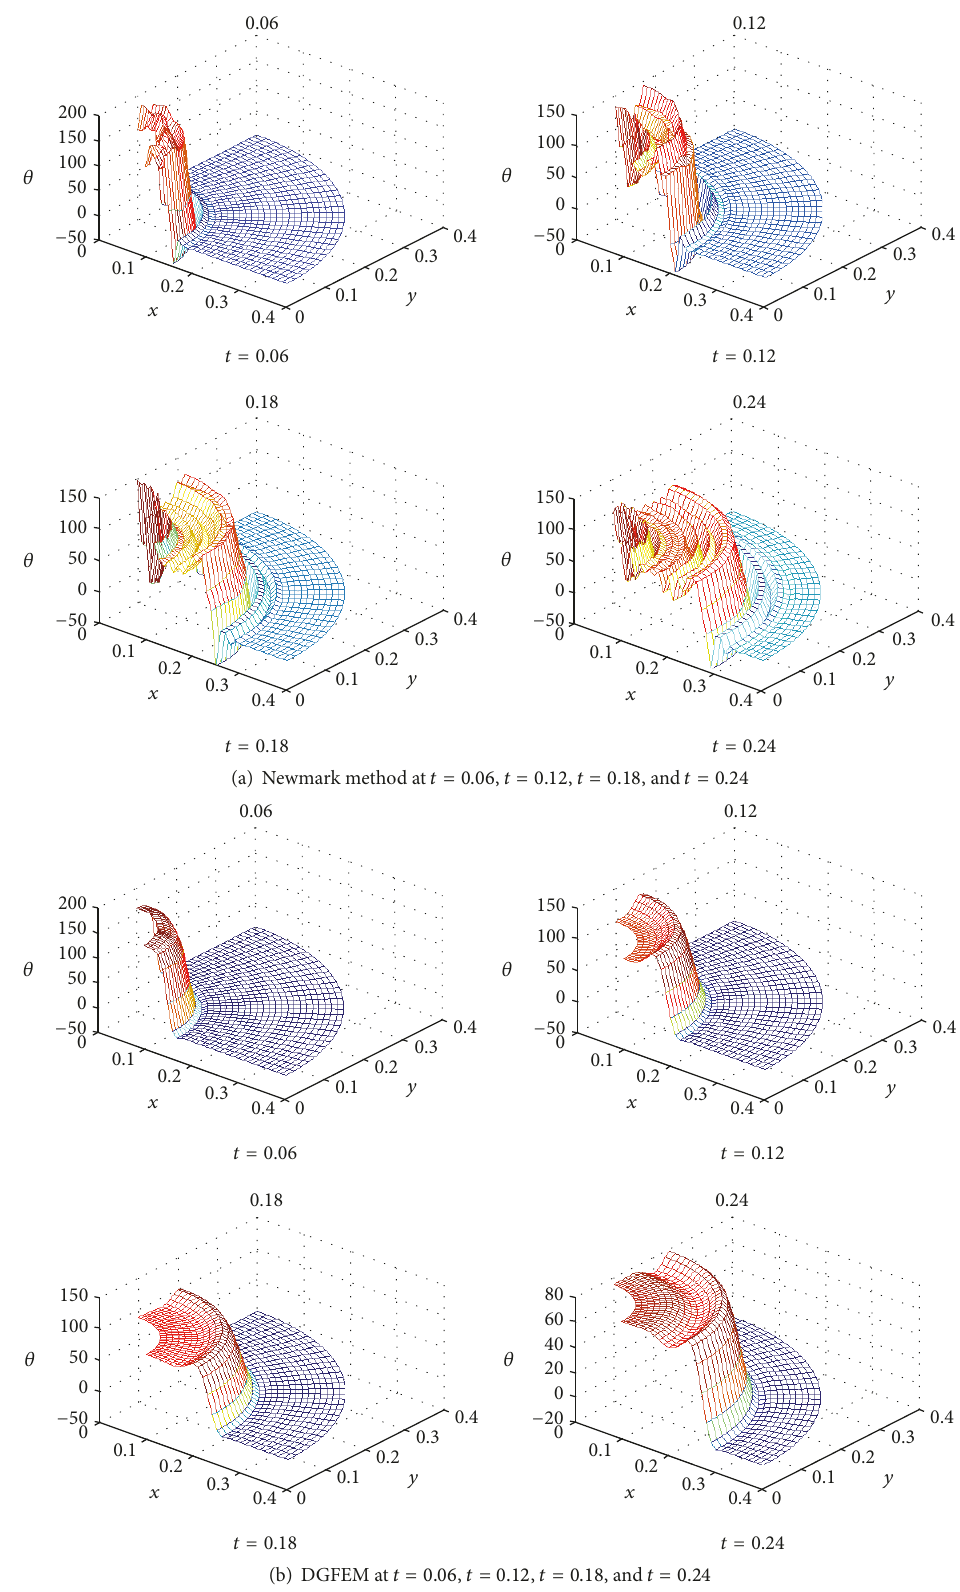
Figure 5: Comparison of the temperature distributions between the Newmark method and the